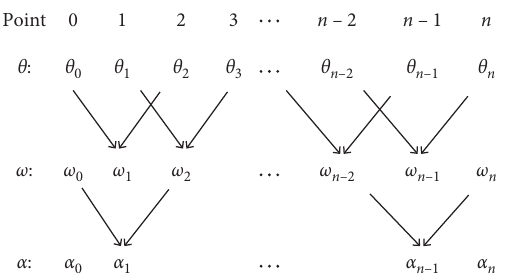
Figure 7: Solution process of interpolation point boundary